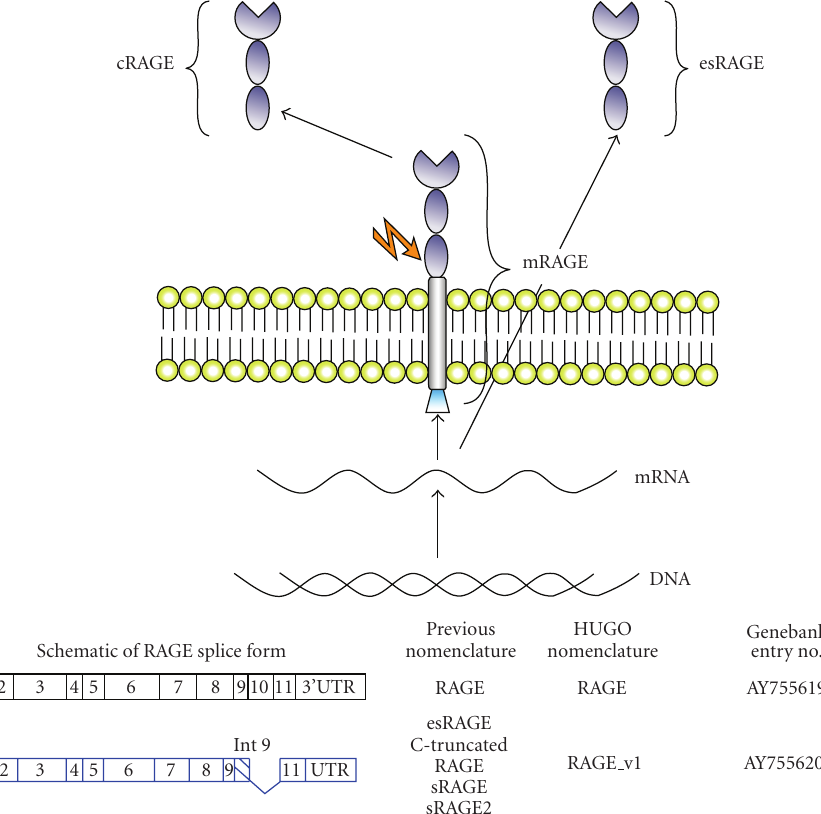
Figure 1: Schematic representation of RAGE and the generation of some of its isoforms commonly found in the lung. In addition to its full-length form (mRAGE), RAGE also exists in a soluble form (sRAGE) which lacks the transmembrane and cytosolic domains found in mRAGE. Production of sRAGE isoforms is via either proteolytic cleavage, which gives rise to cleaved RAGE (cRAGE) or alternative splicing at exon 9 resulting in a C-truncated form termed endogenous secretory RAGE